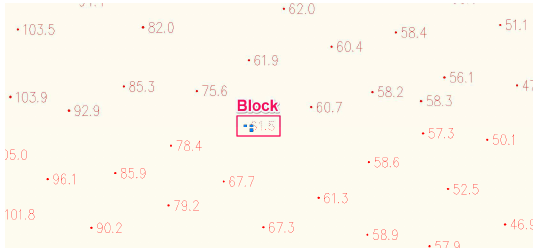
Figure 3. Schematic diagram of elevation points in CAD.